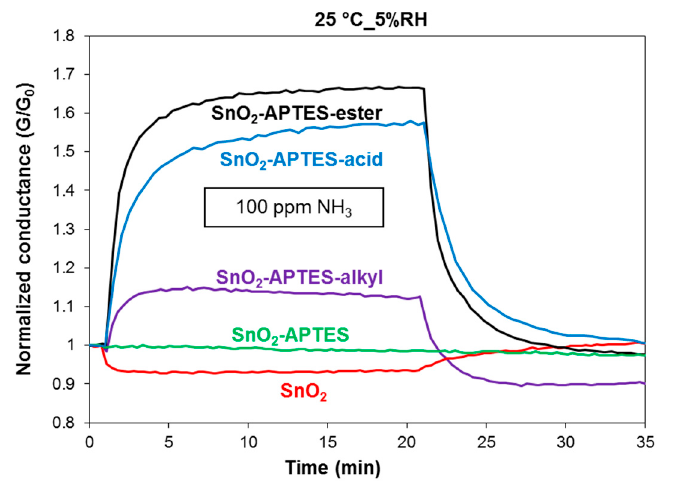
Figure 1. The sensor response of SnO 2 , SnO 2 -APTES, SnO 2 -APTES-alkyl, SnO 2 -APTES-acid and SnO 2 -APTES-ester to 100 ppm of ammonia gas balanced with humid air (5%RH) at 25 °C. G is the conductance at any time and G 0 is the conductance at the beginning of the test ( t = 0).